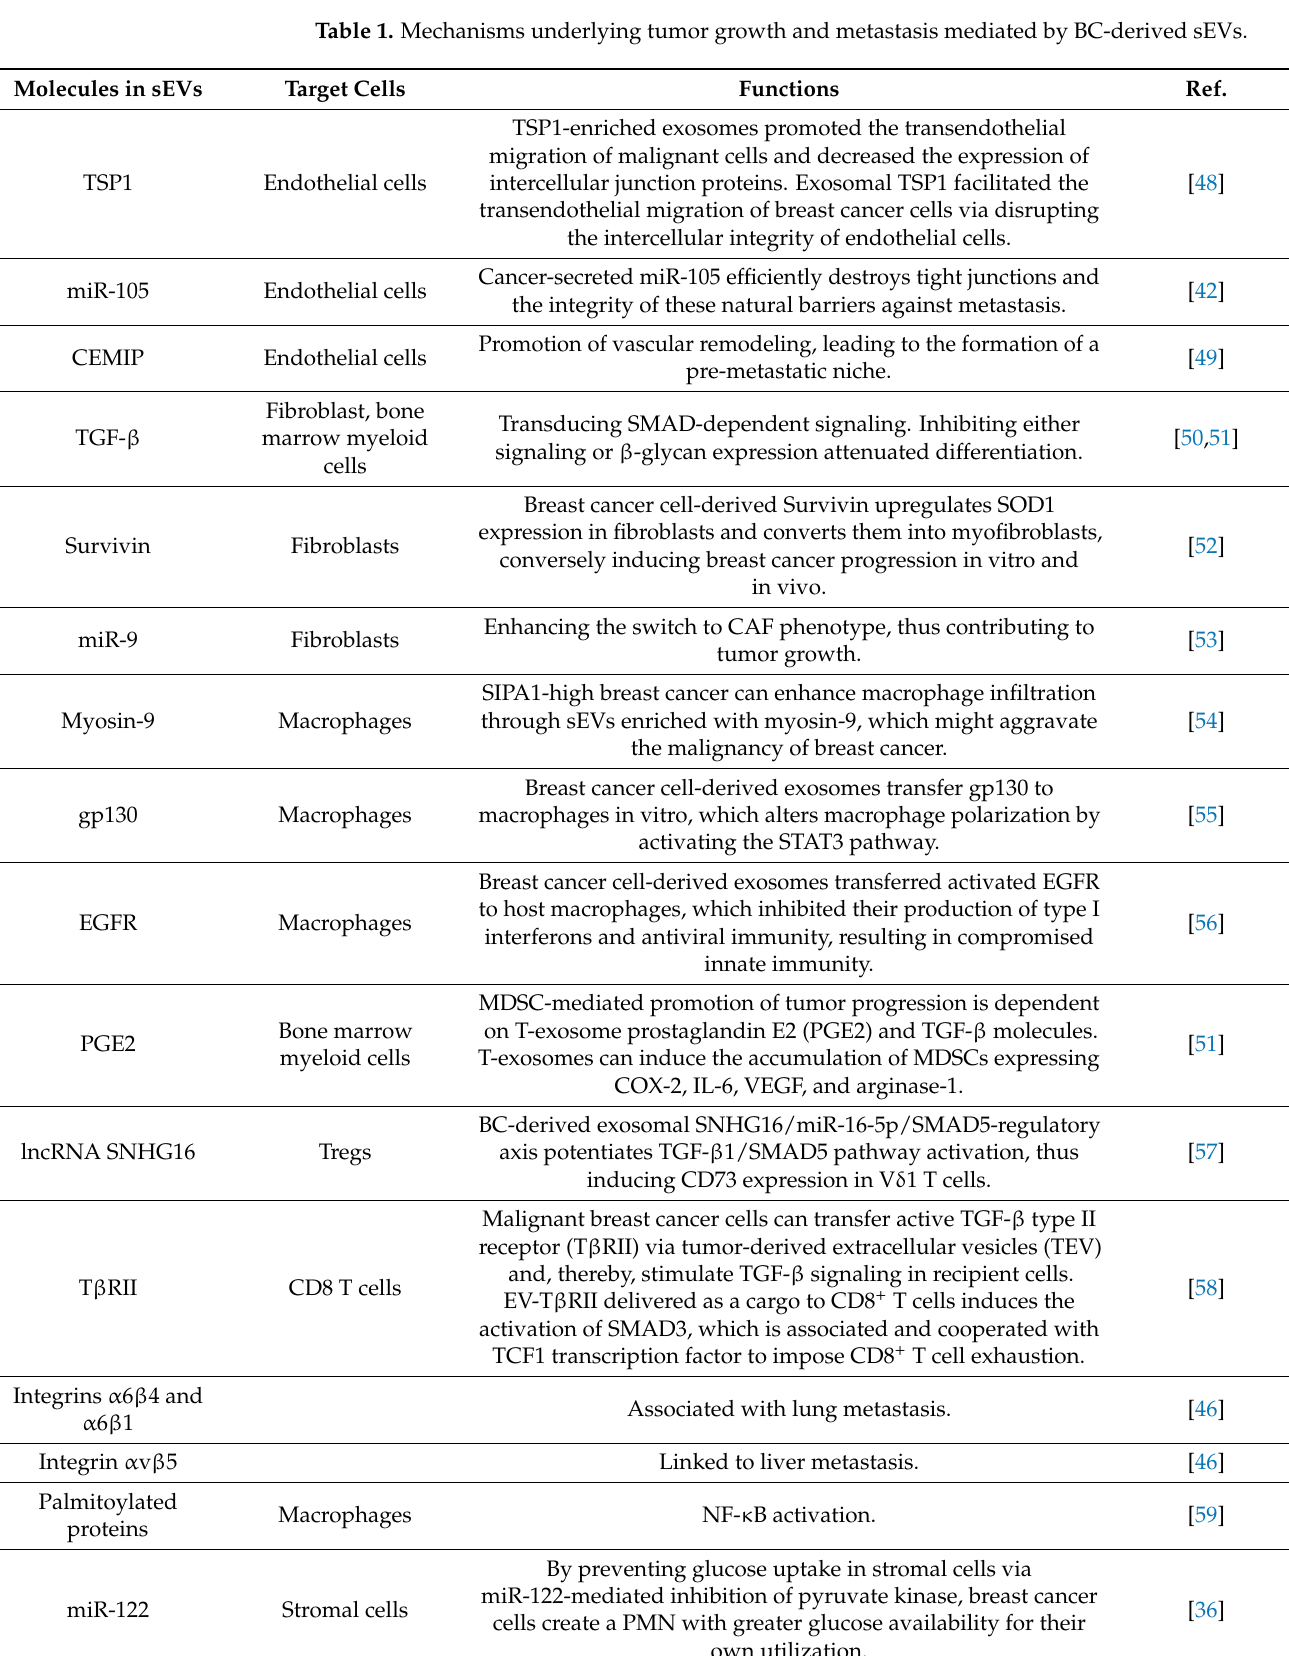
Table 1. Mechanisms underlying tumor growth and metastasis mediated by BC-derived